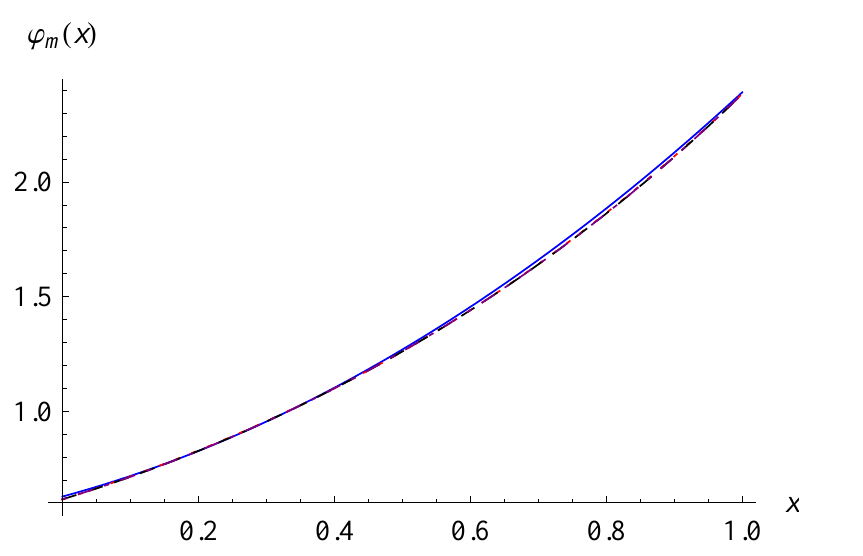
Figure 5. For λ = 1.5, the solution approximations ϕ m ( x ) for m = 2 (solid line), m = 3 (dot line), m = 4 (dash line) and m = 5 (dot-dash